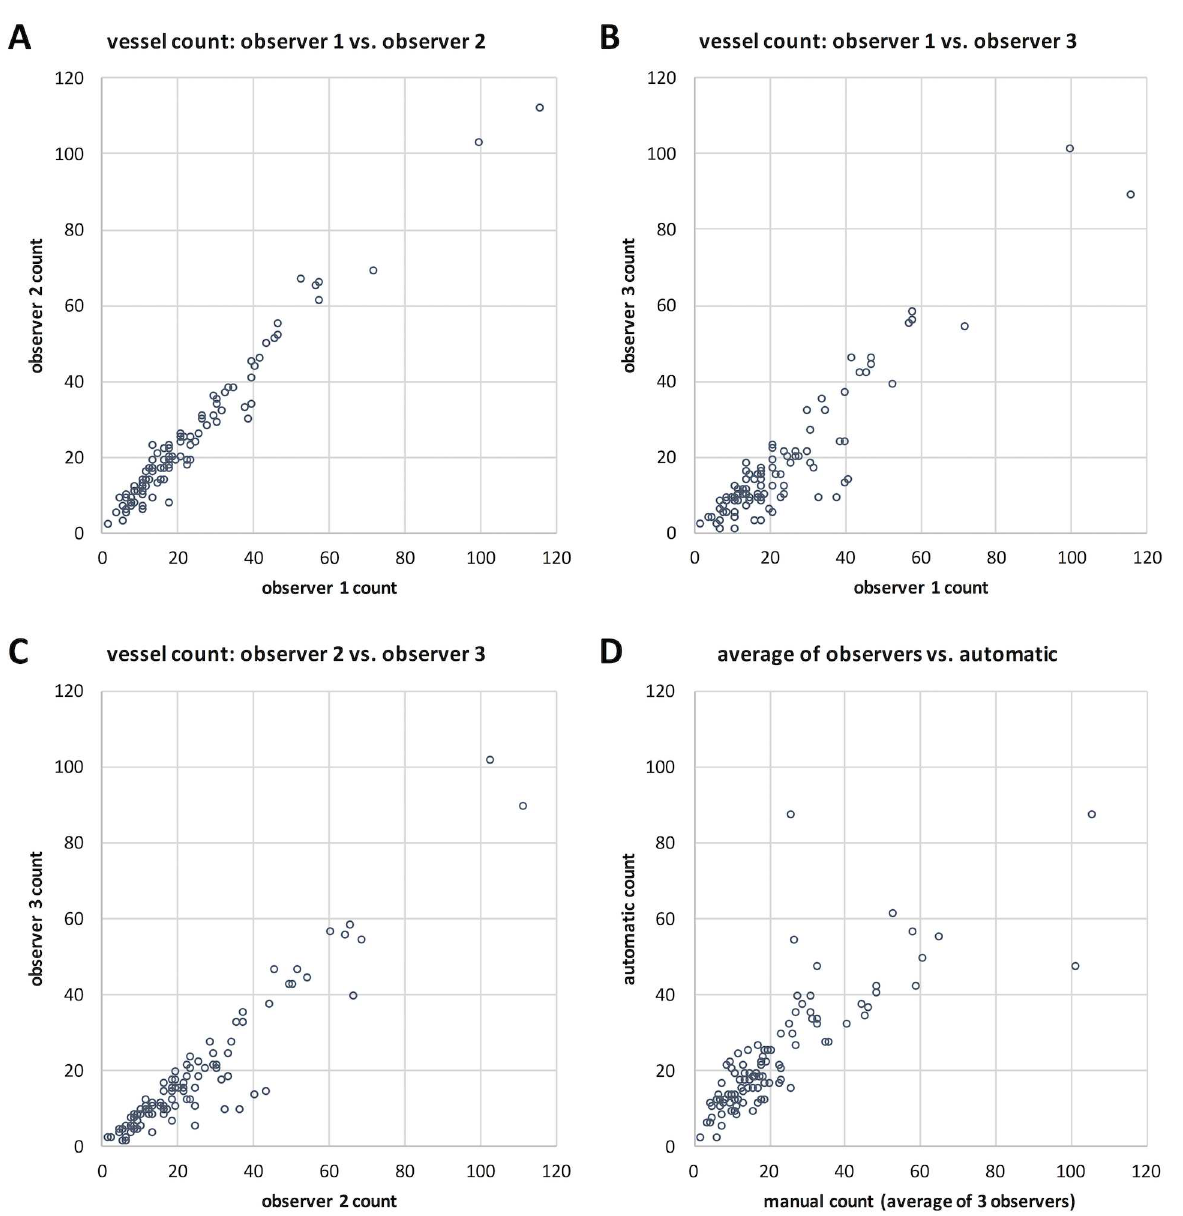
Fig 2. Validation of the segmentation procedure. Blood vessels in N = 100 image patches were countedby three blinded human observers. In each image patch, each observer manually determined the number of blood vessels. Then, for each image patch, these numbers were compared in a pair-wise manner betweenthe three observers. The mean count calculatedfrom the three observerswas comparedto the result of the automatic method. The experimental data are shown as scatter plots. (A-C) Inter-observervariability, (D) Correlation of the automatic count to the mean of